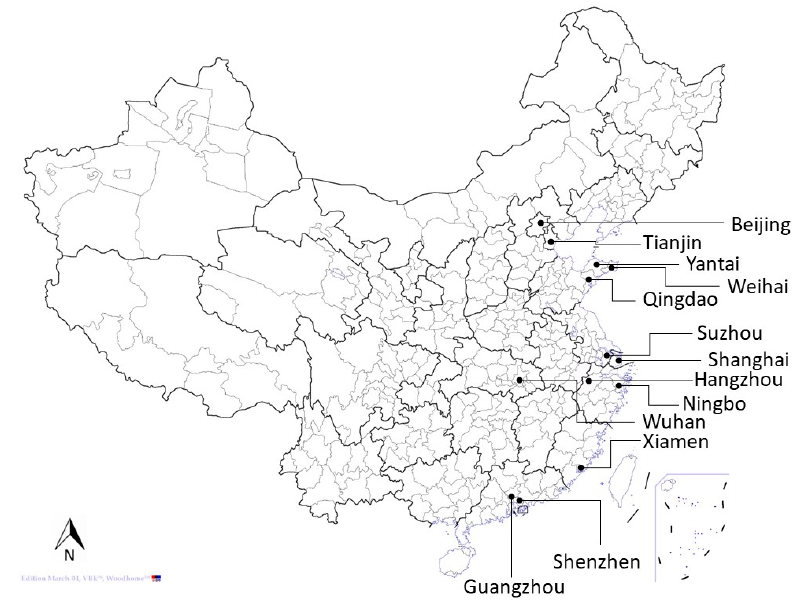
Figure 4. The locations of ZIP codes in Type 1 and 2.